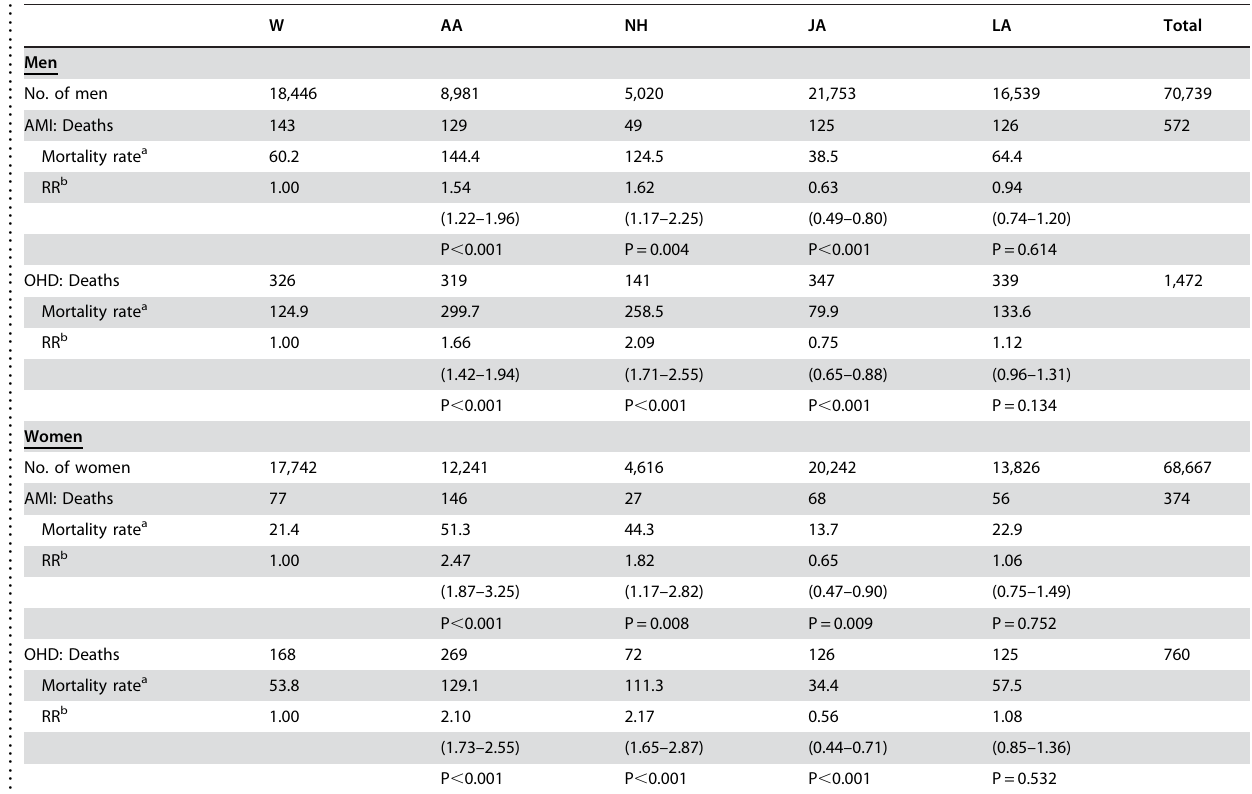
Table 1. Mortality rates from AMI and OHD by race and gender in the MEC. .. ... .... ... ... .... ... ... .... ... ... .... ... ... .... ... ... .... ... ... .... ... ... .... ... ... .... ... ... .... ... ... .... ... ... .... ... ... .... ... ... .... ... ... . W AA NH JA LA Total